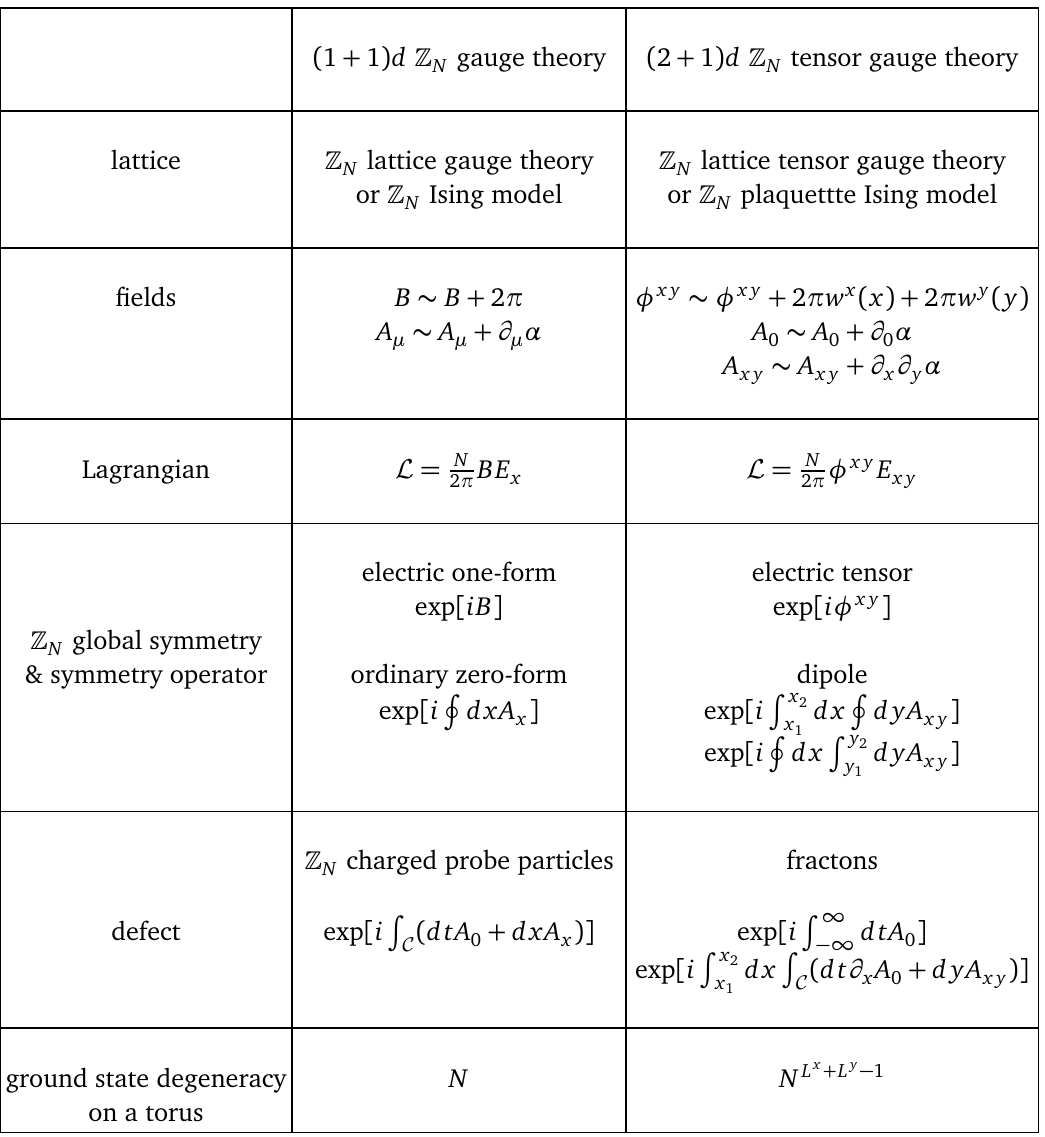
gauge theory and N